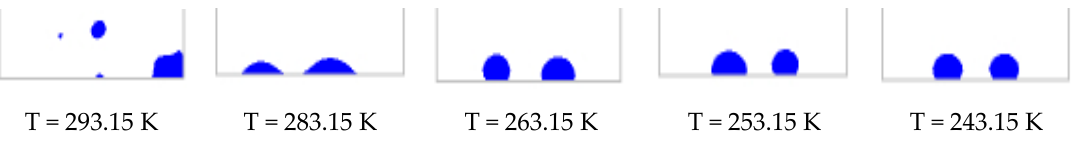
T = 293.15 K T = 283.15 K T = 263.15 K T = 253.15 K T = 243.15 K Figure 16. Water droplets at 0.20 s. Grey line is the solid bottom; blue is water droplet.